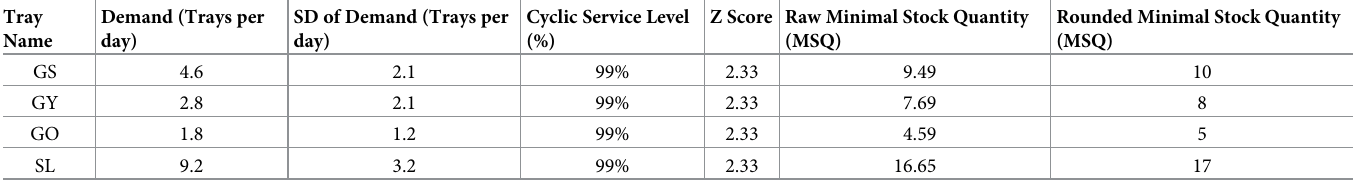
Table 1. Variables for Newsvendor formula used to determine MSQ per tray.